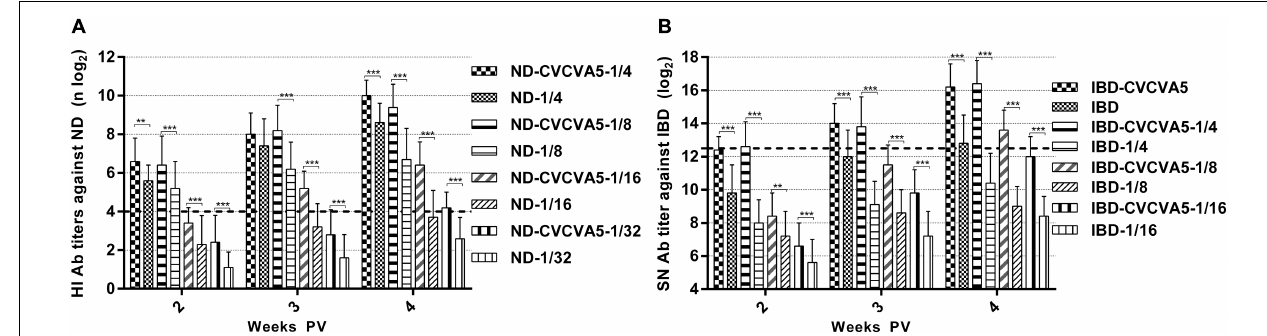
FIGURE 2 | Antibody titers in the minimal dosage of ND and IBD vaccine test. Groups of 3-day-old SPF chickens ( n = 15) were used to determine the efficacy of CVCVA5 on the minimal dosage of ND and IBD test. 1/4th (0.075 ml), 1/8th (0.038 ml),1/16th (0.019 ml), or 1/32nd (0.01 ml) dose of ND mixed with 0.1 ml volume of oil emulsion form of CVCVA5 or oil emulsion with only PBS in the aqueous phase as control, respectively (A) . One dose (0.3 ml), 1/4th (0.075 ml), 1/8th (0.038 ml), or 1/16th (0.019 ml) dose of IBD vaccine were mixed with 0.1 ml volume of the oil emulsion form of CVCVA5 or with the similar oil emulsion containing only PBS in aqueous phase as control, respectively (B) . Chickens were bled at 2, 3, and 4 weeks PV. ∗∗ P < 0.01, ∗∗∗ P < 0.001. TABLE 1 | The Newcastle Disease virus (ND) and Infectious Bursal Disease virus (IBD) shedding post-challenge. Challenge virus Groups Positive swabs of cloaca Positive swabs of oropharynx Total positive Morbidity Mortality 3 dpc 5 dpc 7 dpc 3 dpc 5 dpc 7 dpc